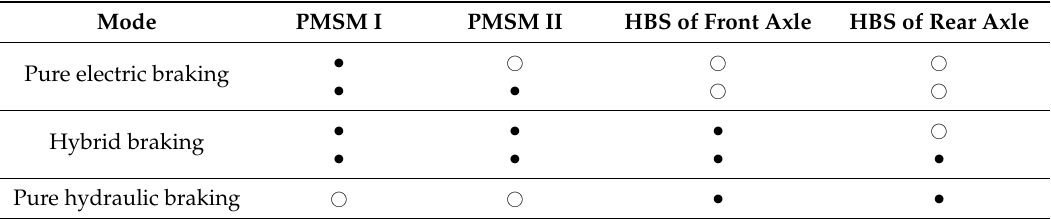
Table 7. The working state of each component in the different braking modes.